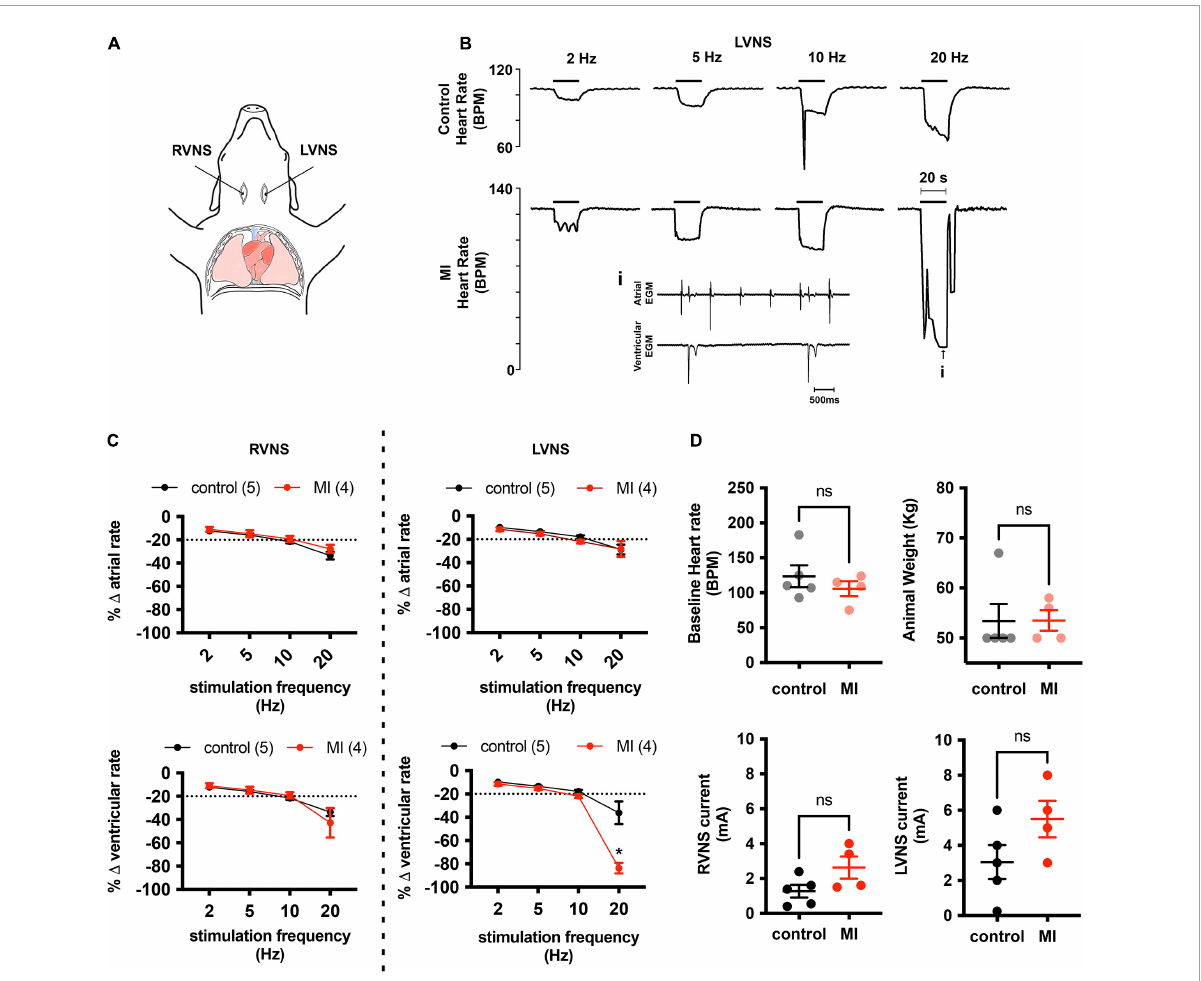
FIGURE1 MI hearts are more susceptible to AV conduction block during stimulation of the left vagus nerve. (A) Cardiac responsiveness to cervical vagal stimulation was assessed in anesthetized, open chest pigs, after bilateral transection of the vagus nerves. RVNS, right vagus nerve stimulation; LVNS, left vagus nerve stimulation. (B) Example tracings of ventricular rate from a control ( top ) and MI ( bottom ) animal during stimulation of the left cervical vagus nerve (LVNS) at 5, 10, and 20 Hz. Note the augmented bradycardic response in MI animal due to AV block ( inset ) during 20 Hz stimulation. This was typical for all MI animals tested. (C) Summary changes in atrial and ventricular rate during stimulation of the right (RVNS) and left (LVNS) cervical vagus. In MI animals, 20 Hz LVNS stimulation produced a significantly greater decrease in ventricular rate due to propensity for AV node block. * Indicates P < 0.05, Šidák’s multiple comparisons test. (D) Baseline heart rate, animal weights, and current intensity for LVNS or RVNS were not different between groups.